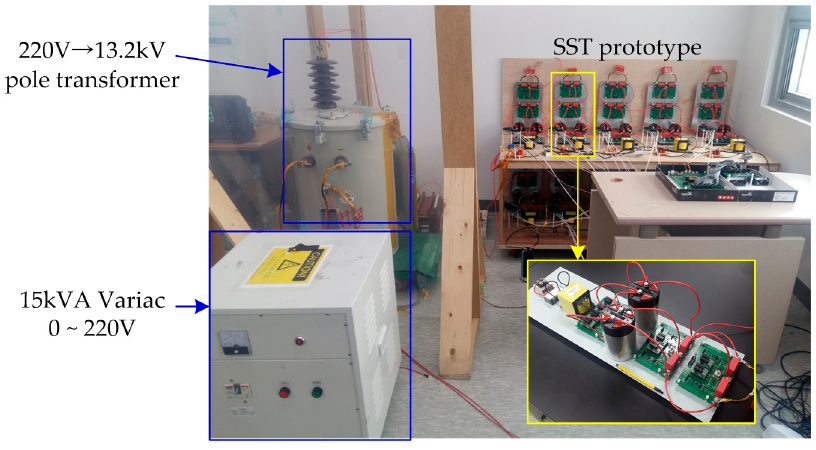
Figure 17. Experimental setup photograph.